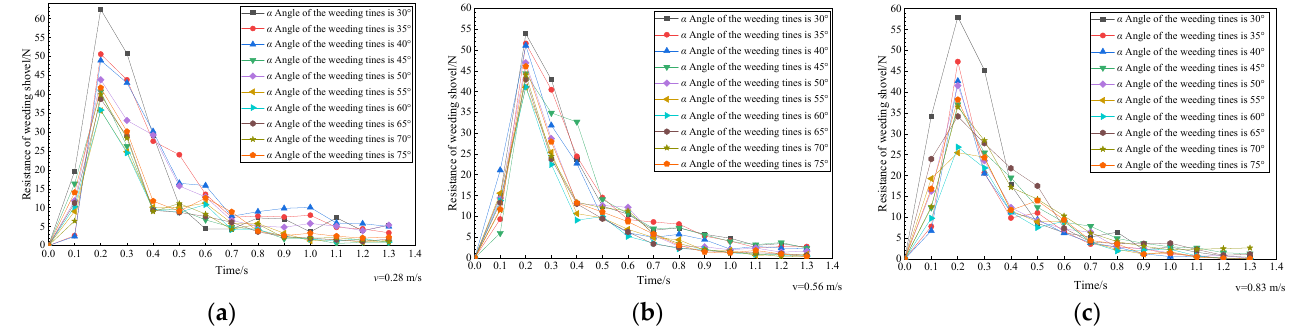
Figure 8. Simulation results of resistance of weeding shovel. ( a ) When the moving speed of weeding shovel is 0.28, the resistance of weeding shovel with different α angle. ( b ) When the moving speed of weeding shovel is 0.28, the resistance of weeding shovel with different α angle. ( c ) When the moving speed of weeding shovel is 0.28, the resistance of weeding shovel with different α angle. Table 5. Statistical table of resistance of weeding shovel.